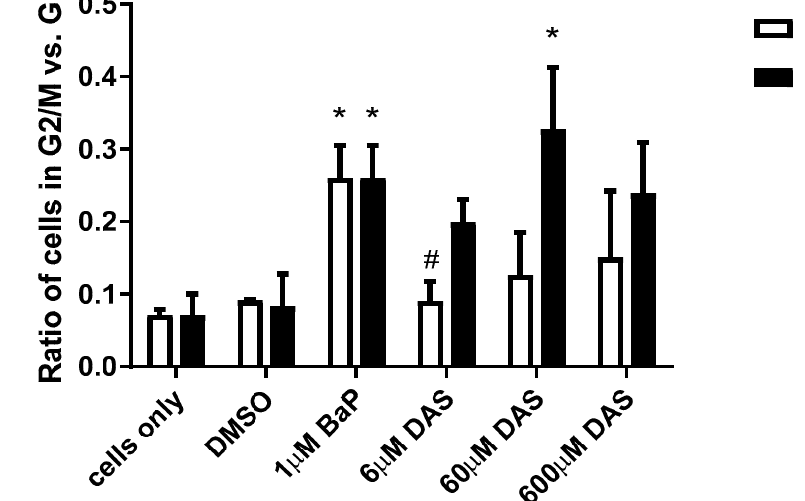
Figure 3. The ratio of cells in G2/M and G1 phases resulting from DAS Pre- and CoTx. The average values for the N = 3 treatments for the cell cycle were compared for the PreTx and CoTx. The values represent the G2/M phase divided by the corresponding G1 phase for N = 3, ± SEM (* indicates a p < 0.05 significant difference from DMSO control, and # indicates a p < 0.05 significant difference from the 1 μ M BaP treatment) at inhibiting the modest BaP-induced increases in cell proliferation after 12 and 24 h of exposure (Figure 1A).